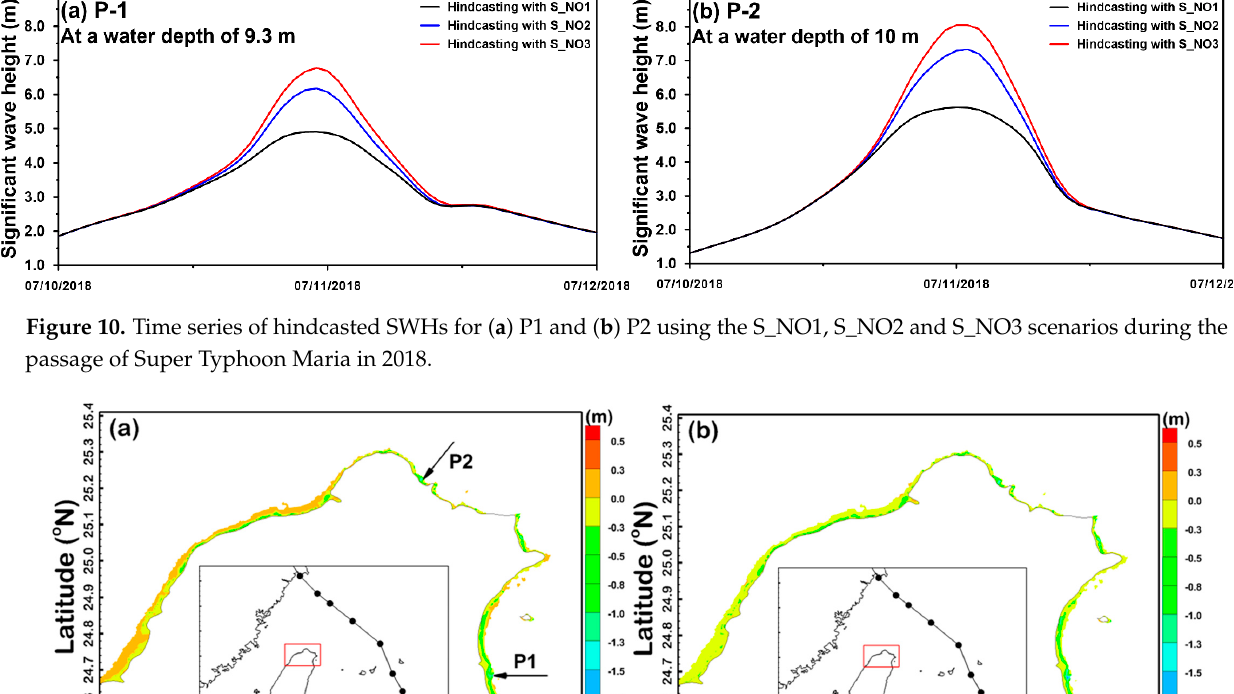
Figure 9. Spatial distribution of the difference in maximum SWH between the scenarios of ( a ) S_NO1 and S_NO2 and ( b ) S_NO1 and S_NO3 during the passage of Super Typhoon Maria in 2018. The areas with water depths greater than − 20 m are shown.